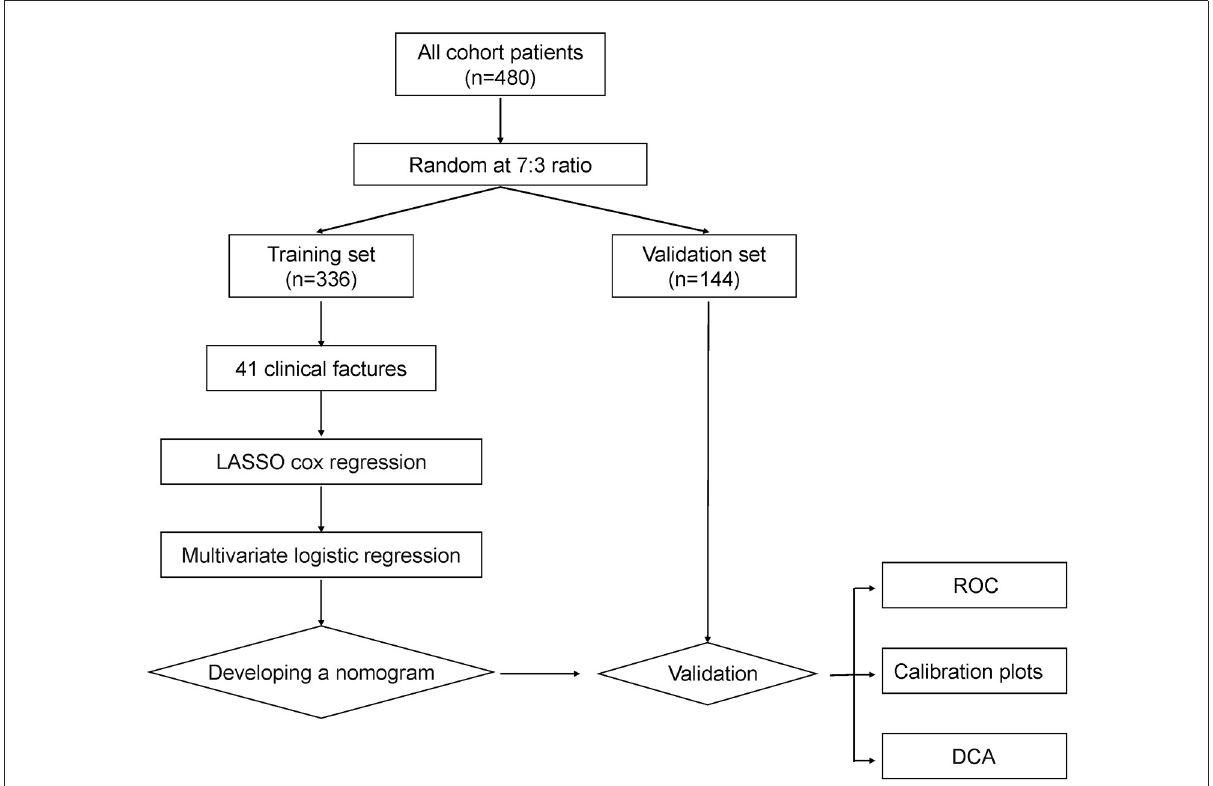
FIGURE1 The flowchart of the study procedure. Abbreviations: LASSO, least absolute shrinkage and selection operator; ROC, receiver operating characteristic; DCA, decision curve